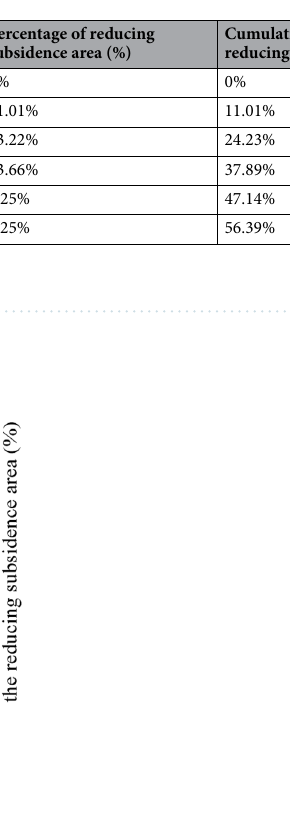
Figure 19. Relationship between reduction in electricity consumption and critical subsidence